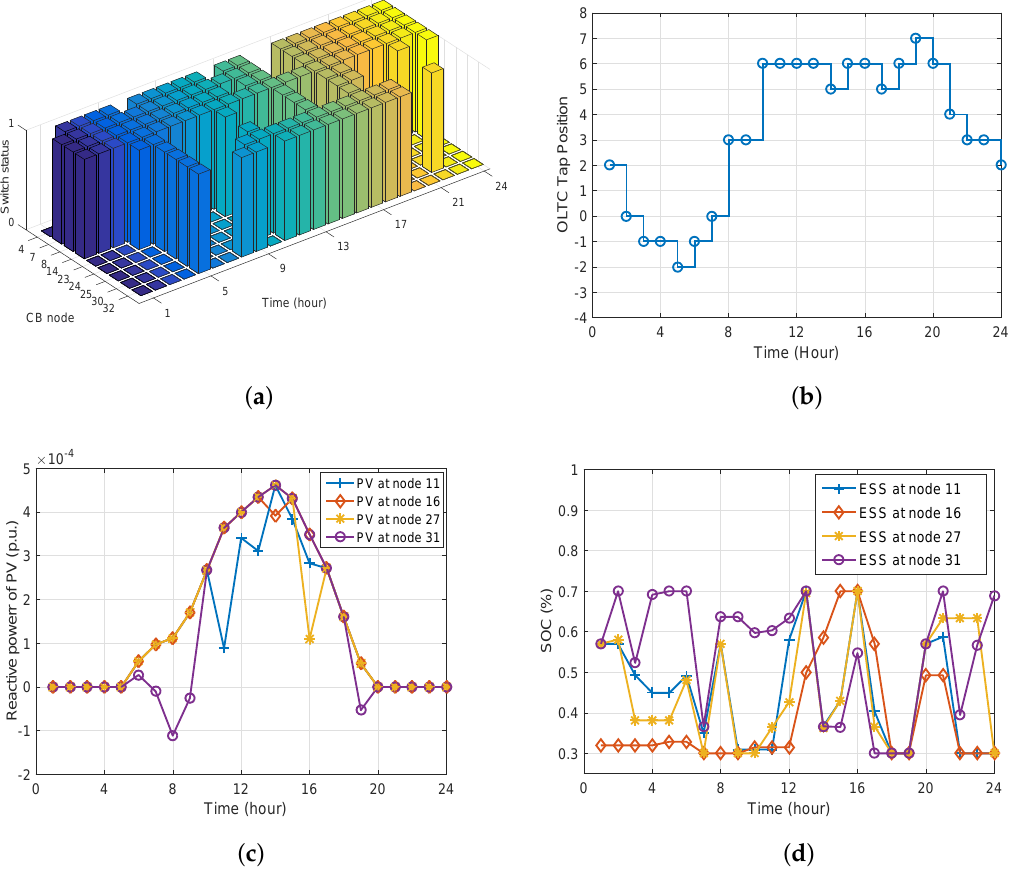
Figure 7. Operating conditions of voltage regulators and distributed energy resources (DERs) in Case 3: ( a ) CBs with optimal switch statuses; ( b ) OLTC with optimal tap positions; ( c ) PV systems with optimal reactive power output; ( d ) ESSs with optimal state of charges